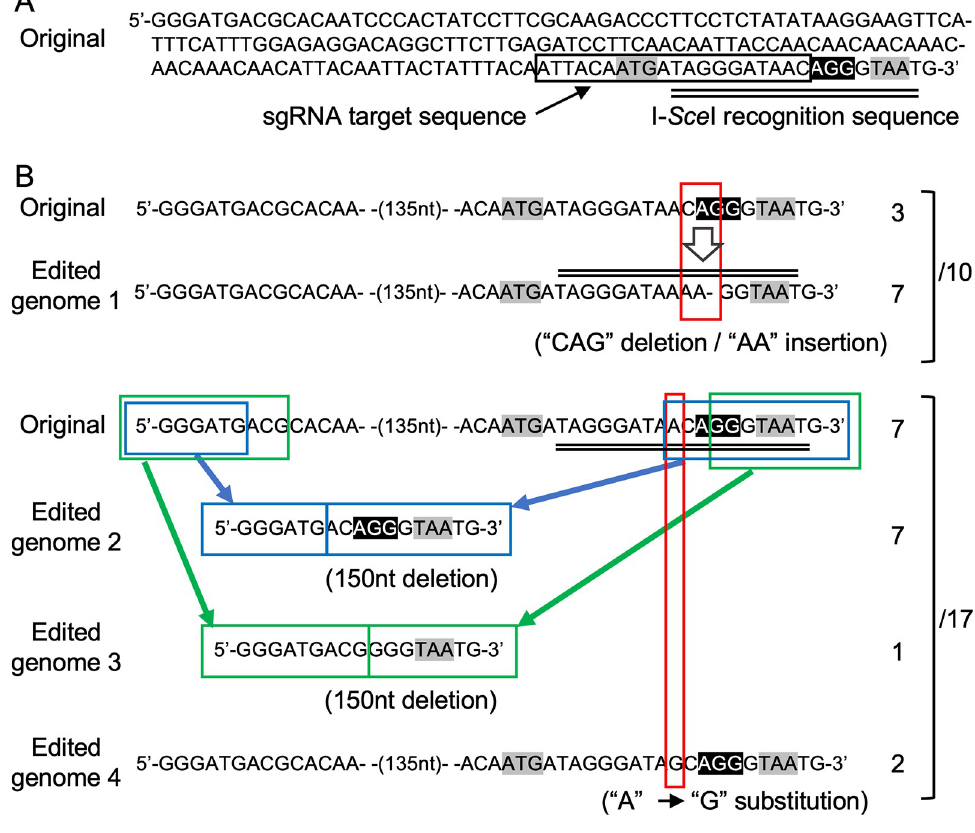
Fig 4. Genome-edited sequences derived from rice